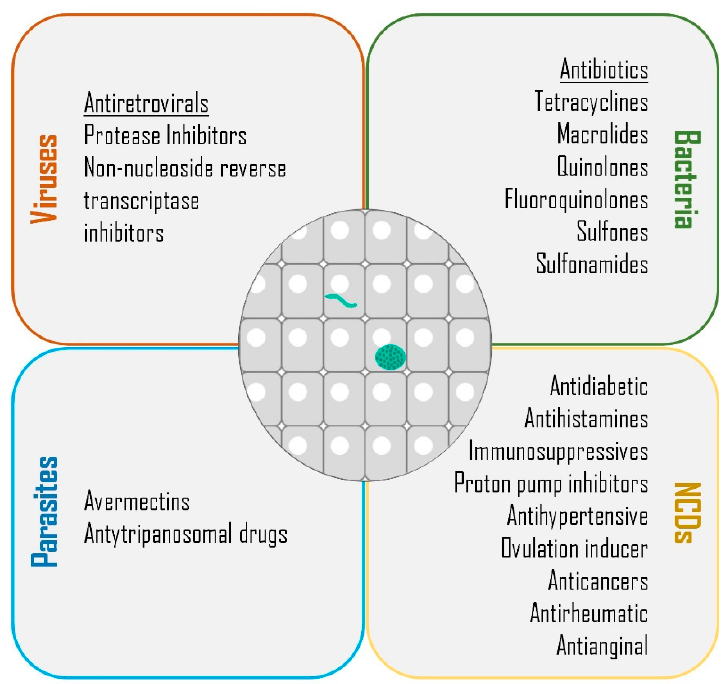
Figure 1. Classes of drugs with demonstrated liver stage activity. Summary of the classes of compounds employed in the management of viral, bacterial, parasitic, and non-communicable or chronic diseases (NCDs) that have been demonstrated to impact the liver stage of Plasmodium parasites.